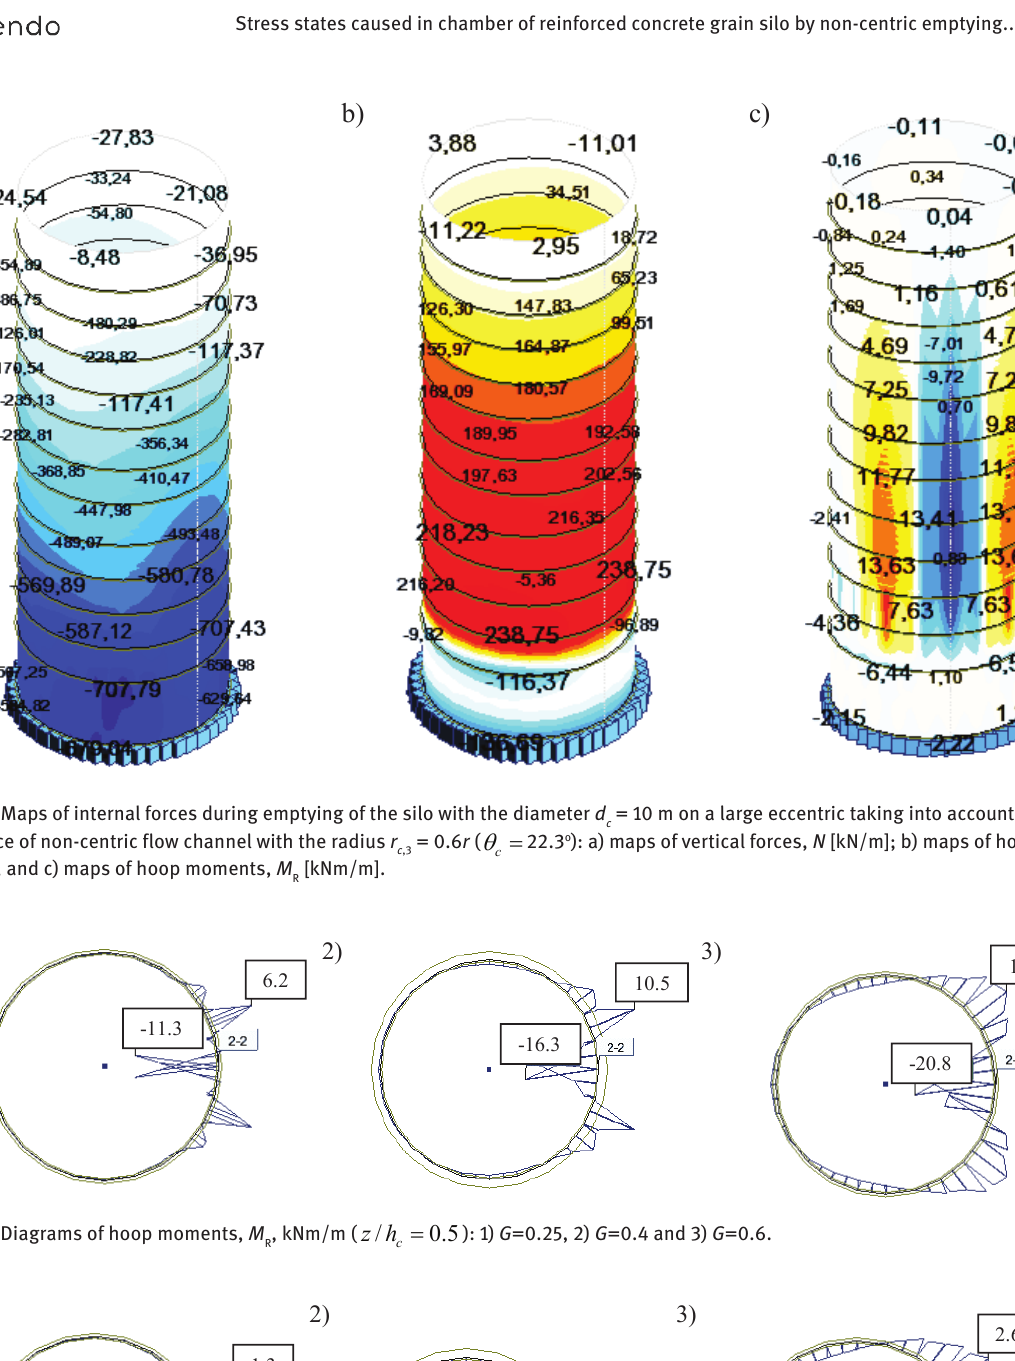
Fig. 5. Values of components of bulk solid pressure on the wall of the silo with diameter d c =10 m and height H =25 m during emptying on large eccentric